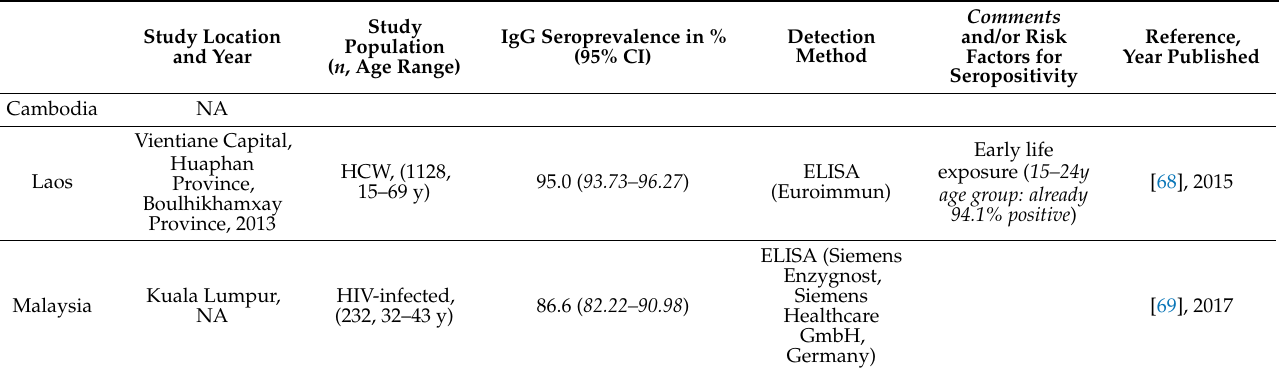
Table 3. VZV IgG serosurveys. Confidence Intervals (CI) in Italics estimated as described in the Methods, HCW = Healthcare workers; EIA = Enzyme immunoassay; y = years; ELISA = Enzyme-linked Immunosorbent Assay; NA = not